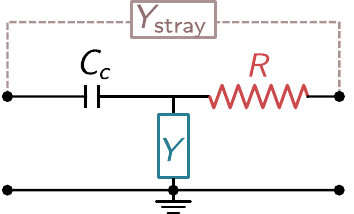
FIG. 6. Quadrupole model of the on-chip components for the calculation of the transmission S 21 . In the ideal case where the external circuit can be fully calibrated by measuring reference samples, S 21 would depend only on C of the junction. In our experiment, this full calibration is not performed, and a weak stray admittance j Y likely dominates our measurements at lower values of S 21 , when the junction admittance is large ðj Y j R ≫ 1 Þ